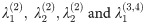
Femoral (a) and tibial (b) remodeling curves for different media stiffening rates. The stiffening rates are multiplied by the parameter σ A hypothetical media whose stiffness remains static in time is represented by σ = 0, while larger values of σ represent a more aggressive MS development (σ=1 corresponds to the values of λ0, λ1(2),λ2(2),λ2(2)andλ1(3,4) in Table E in S1 Appendix).